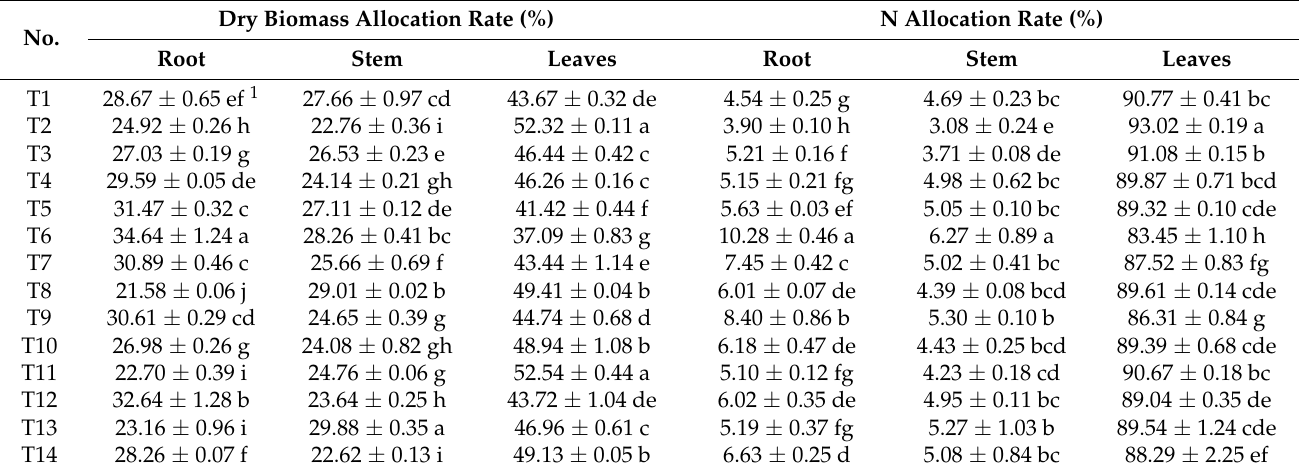
Table 3. Dry biomass and N allocation rate of P. bournei seedlings under different N-P-K fertilization. Dry Biomass Allocation Rate (%) N Allocation Rate (%) No. Root Stem Leaves Root Stem